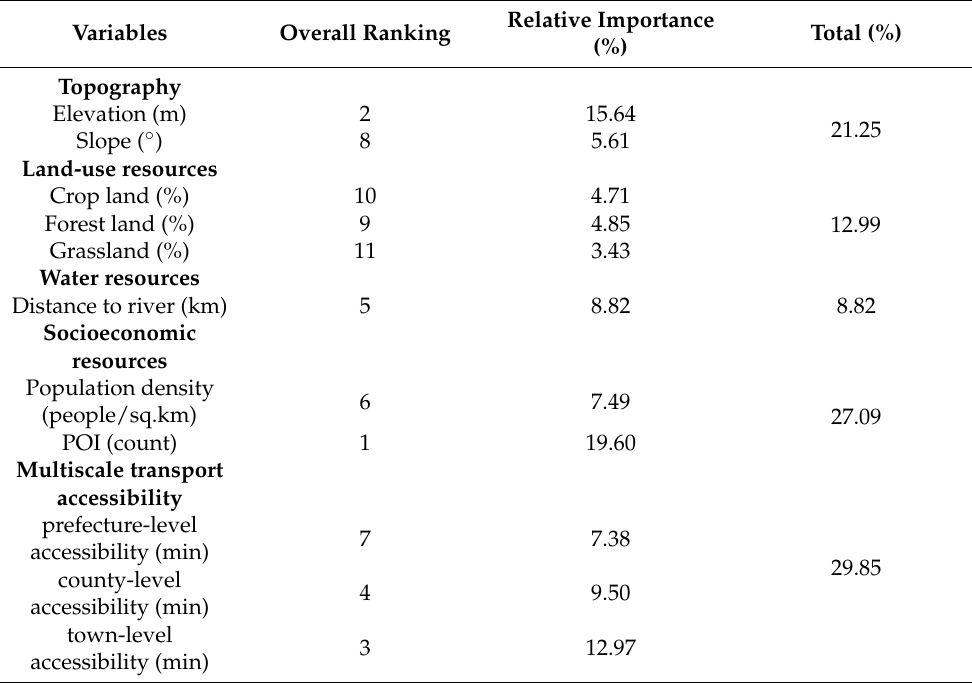
Table 2. Relative importance of independent variables in predicting